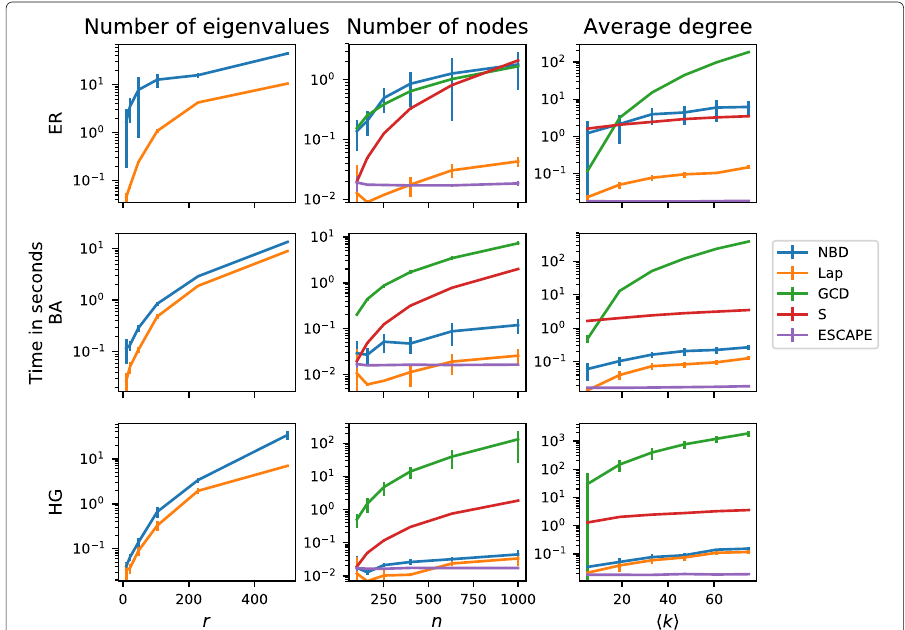
Fig. 9 Runtime comparison. We measure the time it takes to run each distance method on three different random graph models (ER, top; BA, middle; HG, bottom). We investigate the effect of varying three different parameters (number of eigenvalues, left; number of nodes, center; average degree, right). Lines show average, error bars show standard